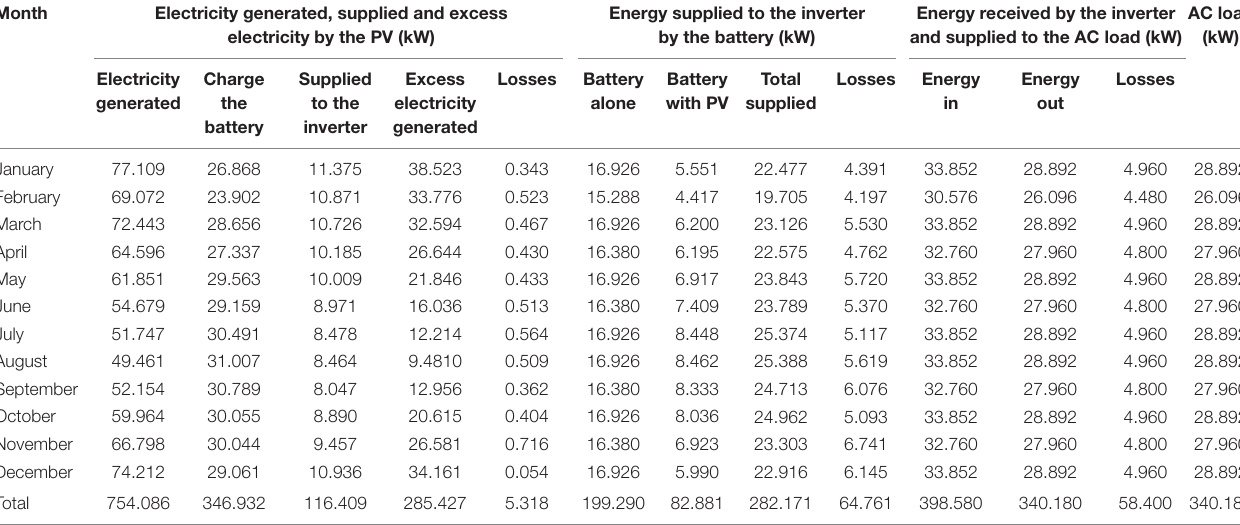
TaBle 5 | simulation results of electricity production, battery charge, supply, excess, losses, and consumption (kWh/year). Month electricity generated, supplied and excess energy supplied to the inverter electricity by the PV (kW) by the battery